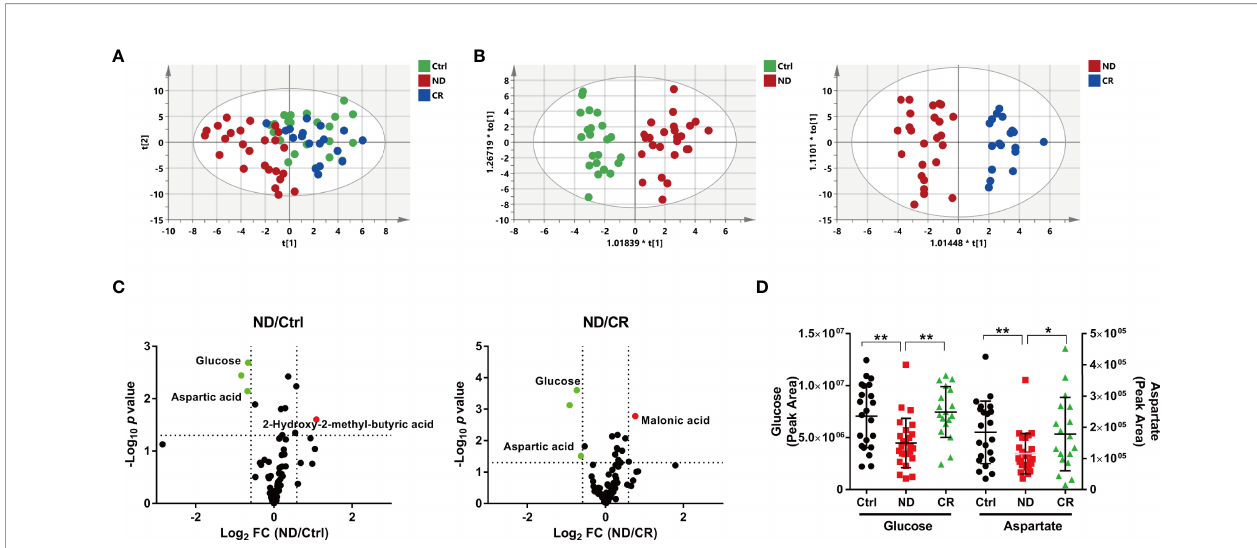
FIGURE 1 | Metabolic patterns and perturbed metabolites of DLBCL patients based on plasma metabolome. (A) The PLS-DA score plot, the parameters of the model were: R2X = 0.306, R2Y = 0.351, and Q2 = 0.176. (B) The OPLS-DA score plot of the Ctrl group vs. the ND group, the parameters of the model were: R2X = 0.222, R2Y = 0.855, and Q2 = 0.532. The OPLS-DA score plot of the CR group vs. the ND group, the parameters of the model were: R2X = 0.381, R2Y = 0.872, and Q2 = 0.587. (C) Volcano maps of the metabolites identi fi ed from the Ctrl group and the ND group (left) and the CR group and the ND group (right). Red dots represent metabolites with higher abundance while green dots represent metabolites with lower abundance in the ND group. (D) The plasma abundance of glucose and aspartate. ND: patients newly diagnosed; CR: patients achieving complete remission. *: p < 0.05; **: p <